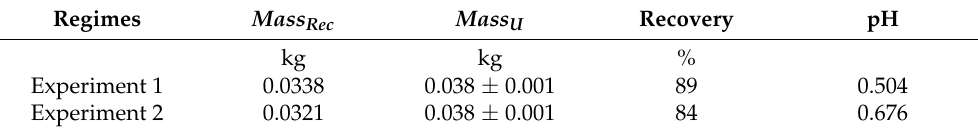
Table 4. Initial Mass U and extracted Mass Rec uranium mass, and recovery for the two